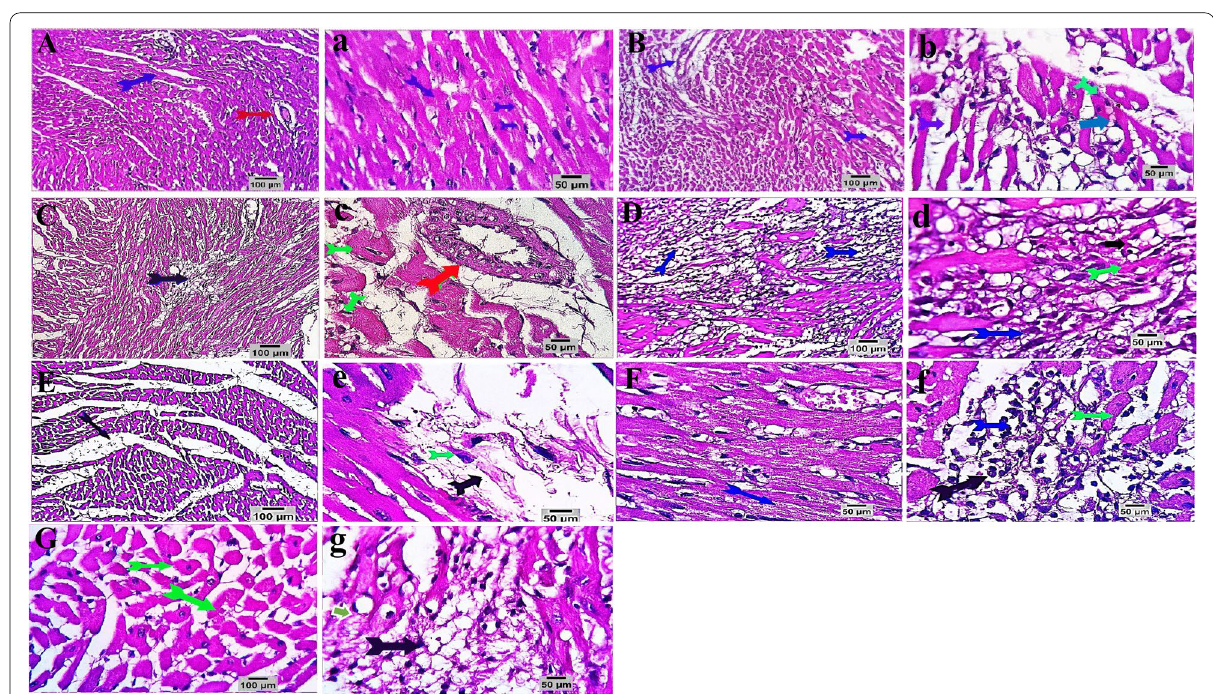
Fig. 4 Representative photomicrographs of cardiac tissue sections of rat groups stained with H&E. ( 200). ( A,a ): Normal control group showing × typical normal pattern of cardiac muscle fibers (arrow) and normal vascular structures (bi‑forked thick arrow). ( B,b ): ISO group showing focal atrophic, apoptotic, degenerative and necrotic changes in some muscle fibers (light head arrow). Interstitial and perivascular edematous reactions, fatty degeneration and cardiomyolysis are also seen (arrow& curved thick arrow). ( C,c ): LY294002 ISO group showing focal atrophic, degenerative + and apoptotic changes in some cardiomyocytes (light‑head arrow), beside focal interstitial and perivascular edematous reaction (thick arrow) with degenerative changes in some vascular walls (bi‑forked thick arrow). Normal heart muscles, intercalated discs and sarcolemmal cells are also seen (bent arrow). ( D,d ): DATS ISO group showing most of the cardiomyocytes and the sarcolemmal cells were apparently normal (arrow), along with + mild focal cardiomyocytic atrophic and degenerative changes (light‑head arrow), and a few cardiomyocytes shows fatty degenerative change (curved arrow). ( E,e ): CAP ISO group showing normal cardiomyocytes, sarcolemmal cells with interstitial tissue (bent arrow). Mild cardiomyocytic + degenerative, apoptotic changes and focal intestinal edematous inflammatory process (light‑head arrow & thick arrow respectively). ( F,f ): DATS LY294002 ISO group showing marked histopathologic changes represented by cardiomyocytic atrophic, degenerative and apoptotic + + changes (light‑head arrow), with a moderate interstitial edematous inflammatory reaction (thick arrow). Other cardiac muscles and structures were apparently normal (arrow). ( G,g ): CAP LY294002 ISO group showing cardiomyocytes suffered atrophic, degenerative and apoptotic changes + + (thick arrow) and a few cells with fatty degeneration (curved arrow). Other cardiac muscles and structures are apparently normal (light‑head arrow).